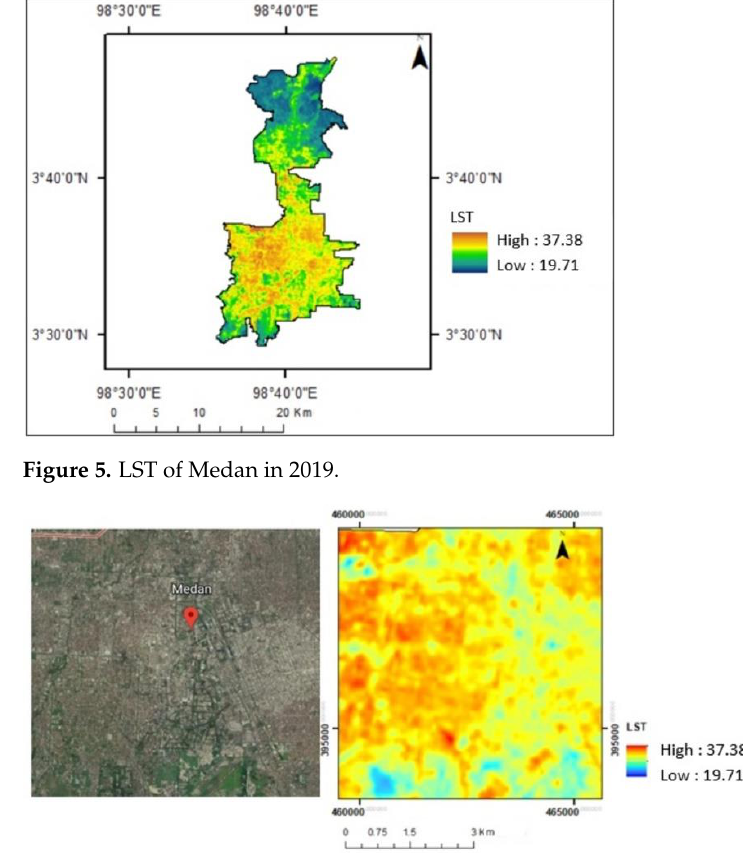
Figure 6. Visualization by Google Earth ( left ) and LST ( right ).